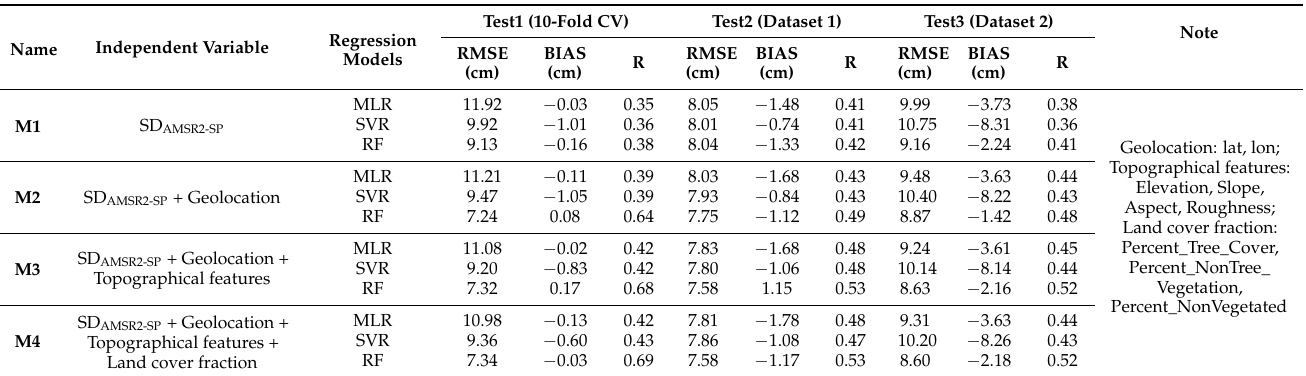
Table 2. A detailed error statistics of the 12 models based on three regression models with four combinations in three test